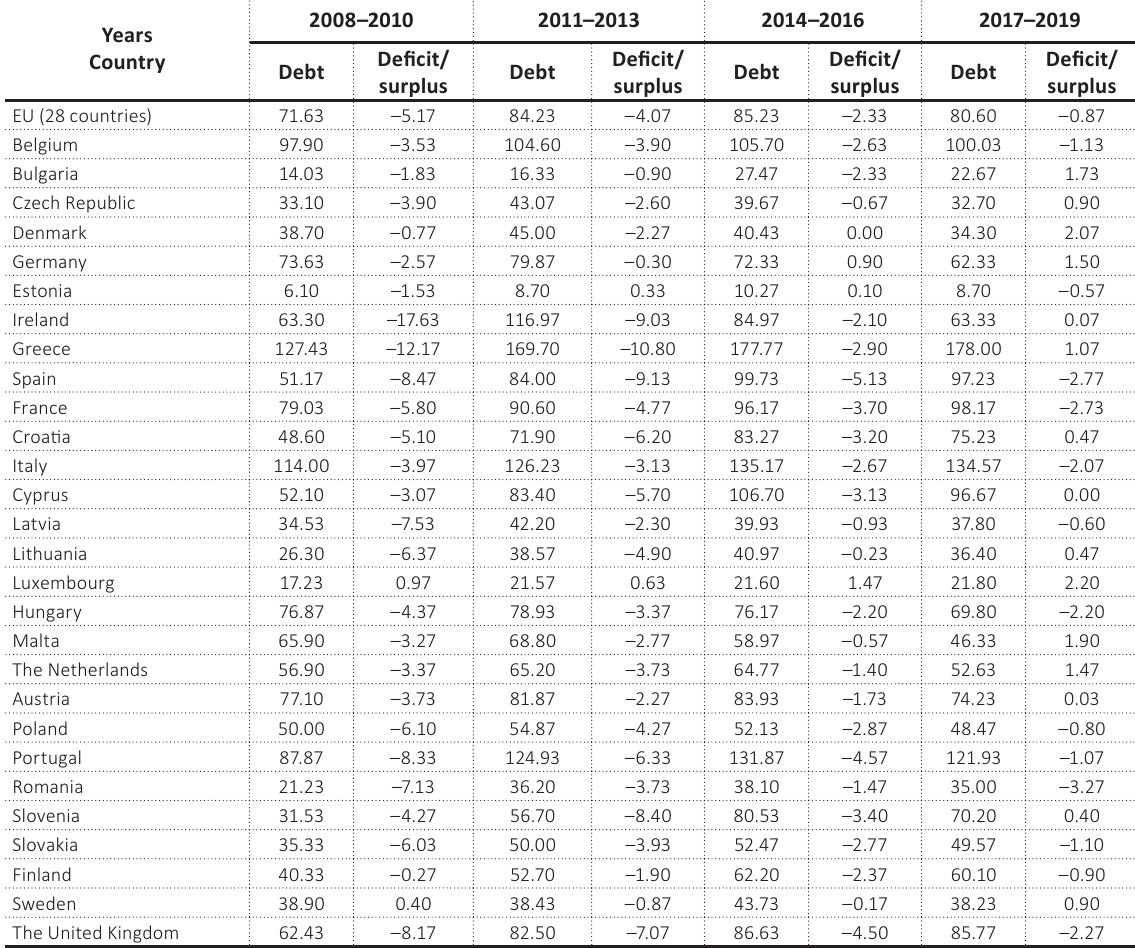
Source: Based on the data from